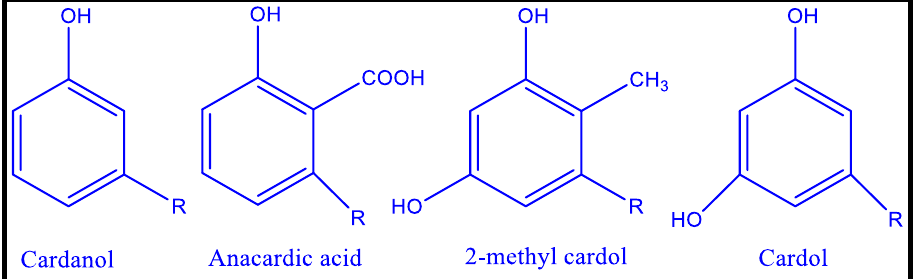
Figure 6. Chemical Structures of CNSL’s Major Components [63].